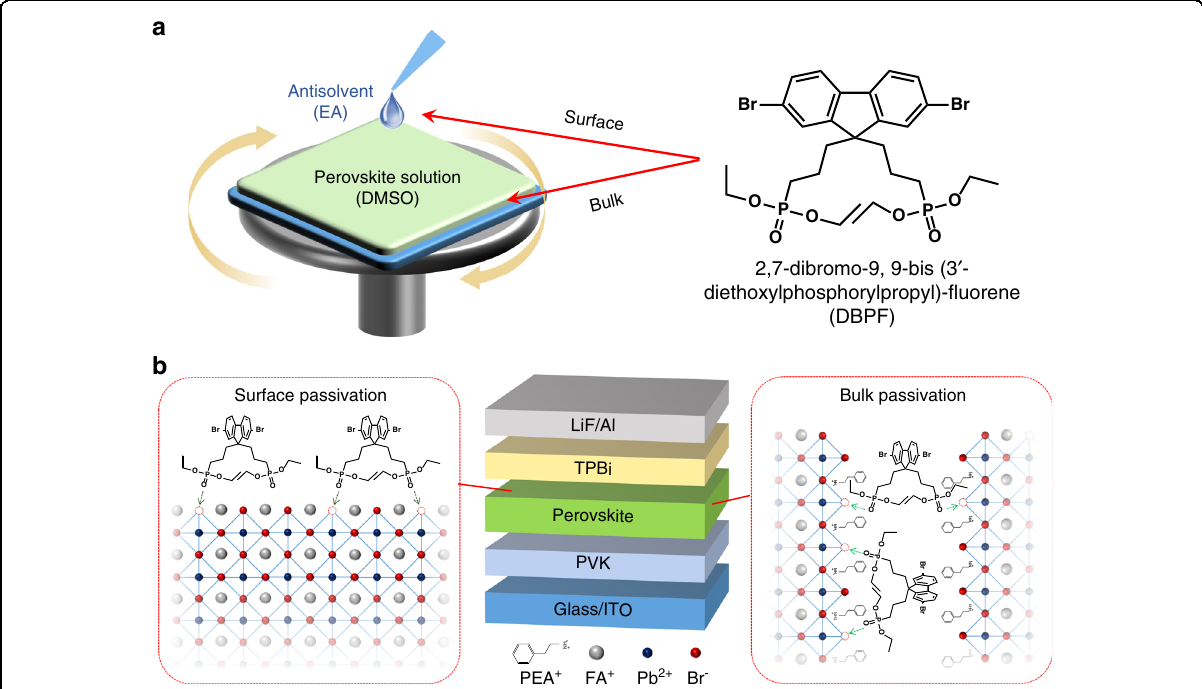
Fig. 2 Methods and mechanisms of defect passivation in quasi-2D perovskite fi lm. a Preparation of quasi-2D perovskite fi lm and molecular chemical structure of DBPF passivation agent. b Schematics of device structure and passivation